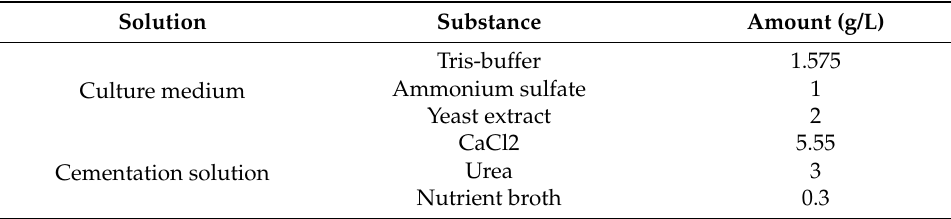
Table 2. Composition of culture and cementation solutions.